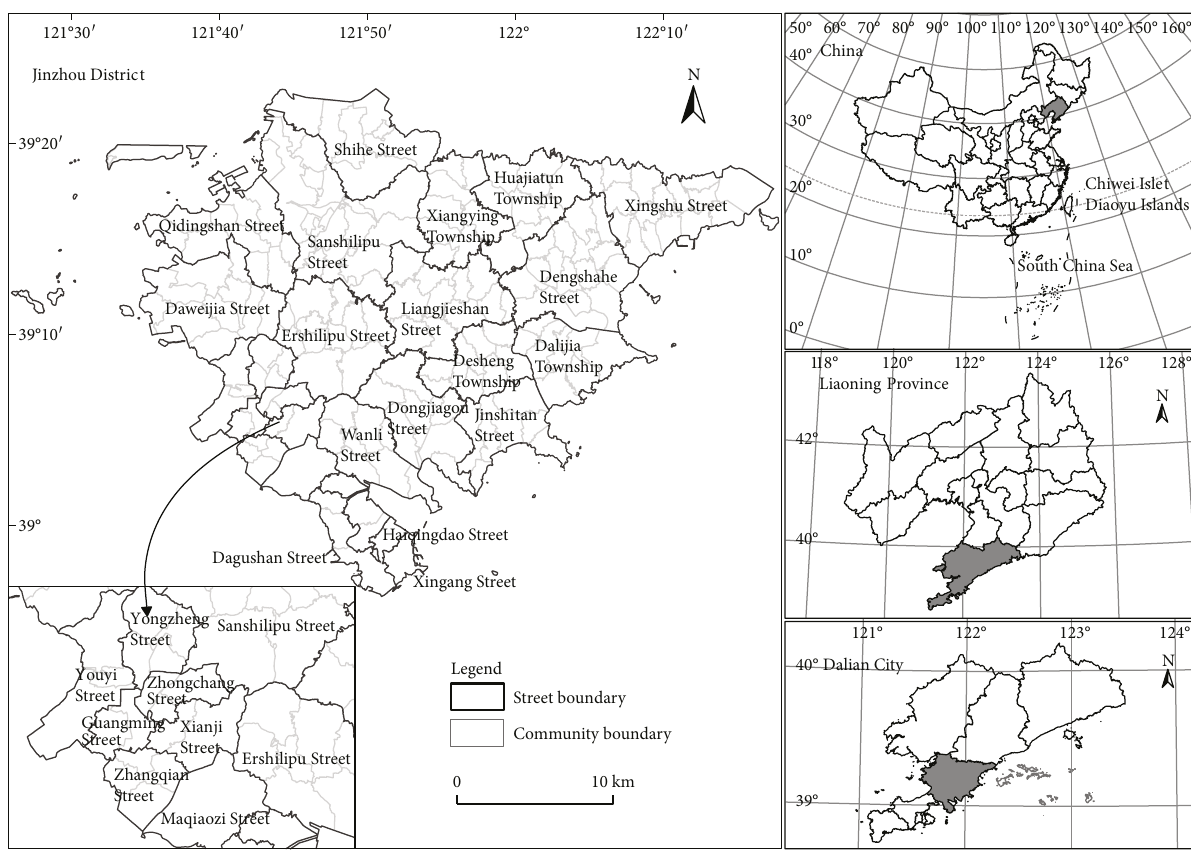
Figure 1: The location of the study